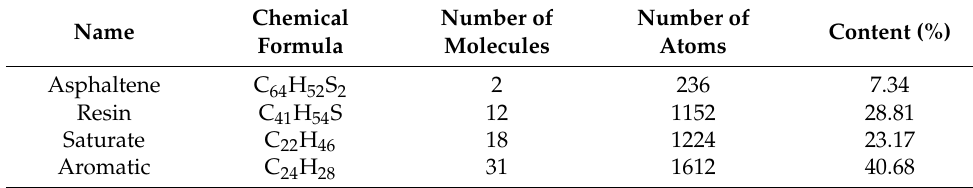
Table 3. The information about molecular models of four asphalt